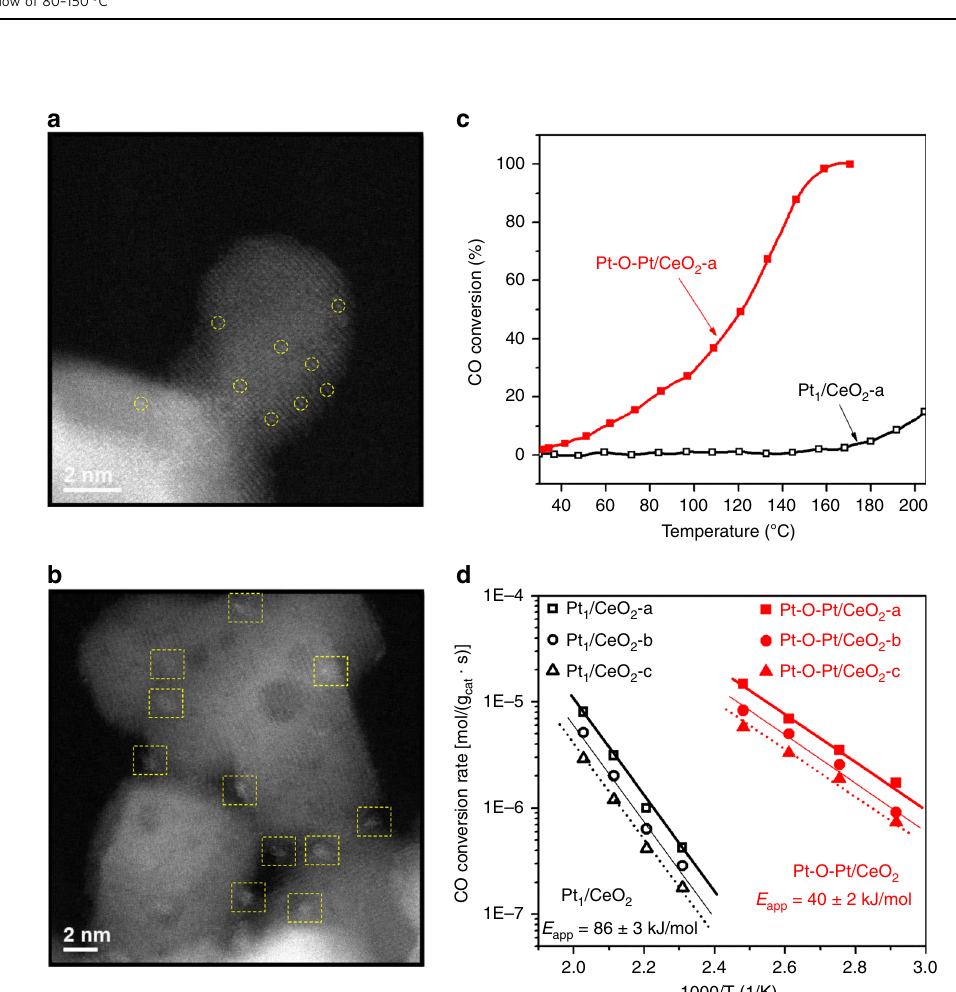
Fig. 1 Direct measurements of the Pt 1 /CeO 2 and Pt-O-Pt/CeO 2 catalysts. a , b Aberration-corrected high-angle annular dark- fi eld scanning transmission electron microscopy (HAADF-STEM) images for the Pt 1 /CeO 2 -a and Pt-O-Pt/CeO 2 -a catalysts (shown images were recorded at ×10 M and ×6 M original magni fi cations, respectively). Yellow circles and squares are used to highlight the single-atom Pt 1 and the Pt-O-Pt ensemble, respectively. c CO oxidation light-off performance ([CO] = 1000 ppm, [O 2 ] = 5%, balanced with N 2 at a contact time of 2,400,000 mL/g cat //h). d Arrhenius-type plot of CO oxidation rates at different temperatures with apparent activation energies ( E app )